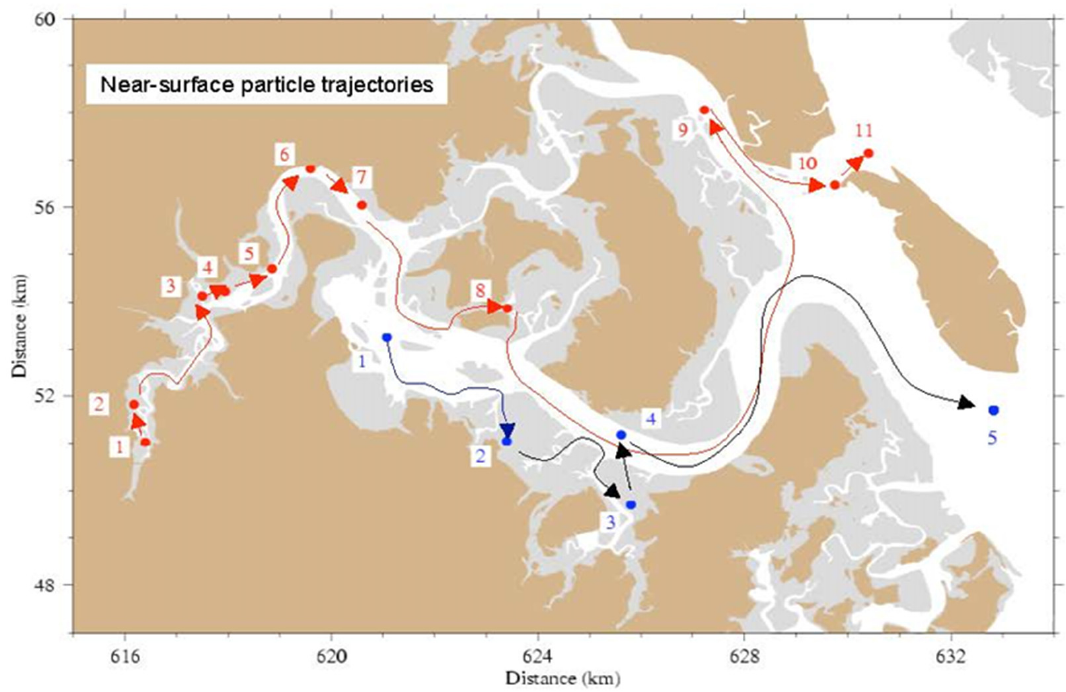
Figure 14. The locations of the particles after each M2 tidal cycle. Numbers in filled white boxes indicate the number of the M2 tidal cycles. Line colors are used to distinguish different particles.